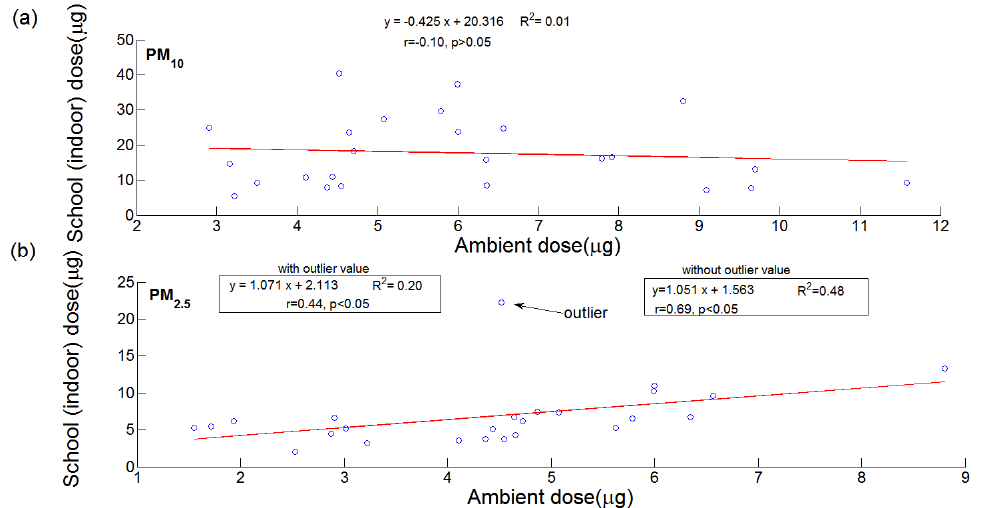
Figure 5. Linear regression between hourly ambient and school indoor dose ( μ g) for ( a ) PM 10 and ( b ) PM 2.5 .